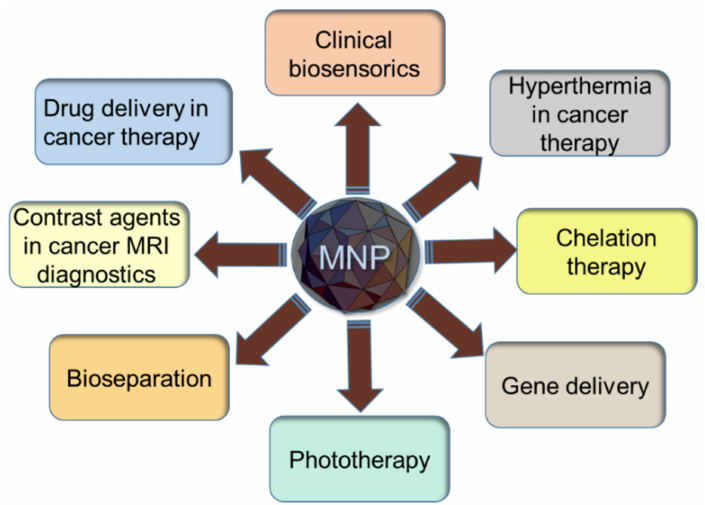
Figure 1. Main clinical applications of magnetic nanoparticles